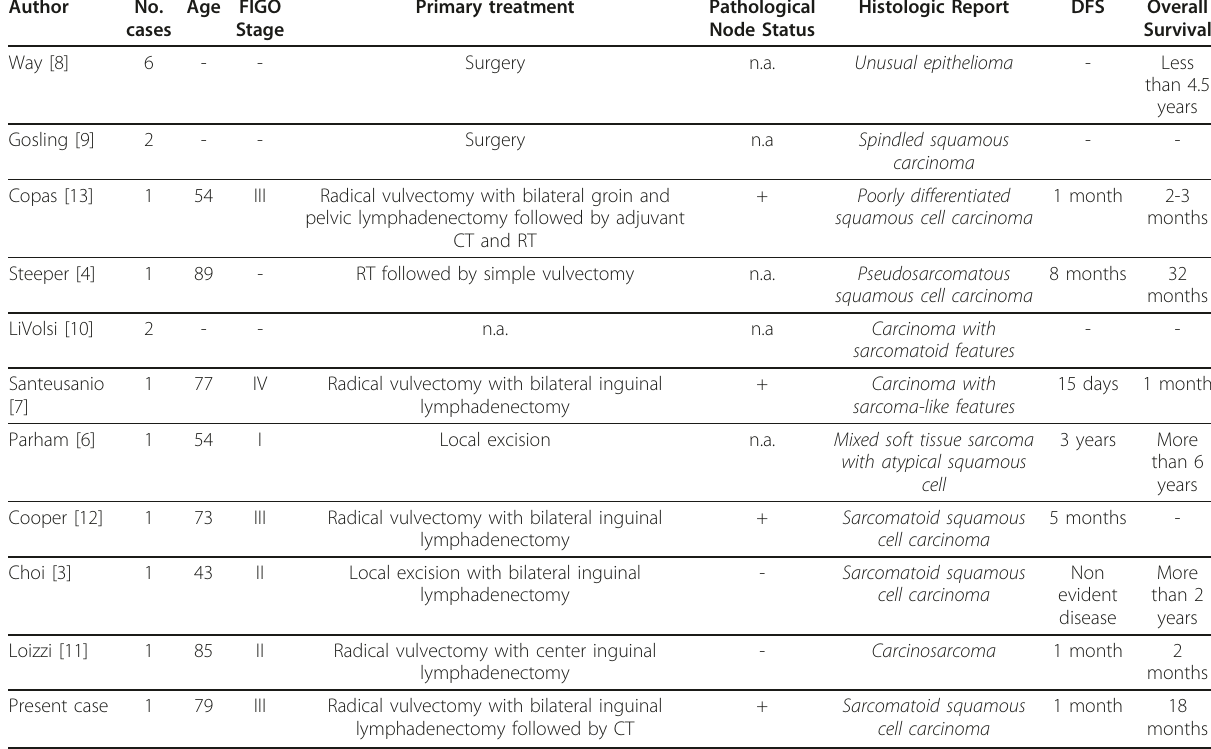
Table 1 Clinico-pathological characteristics, treatment details, and follow-up status of the previously published cases of sarcomatoid squamous cell carcinoma of the